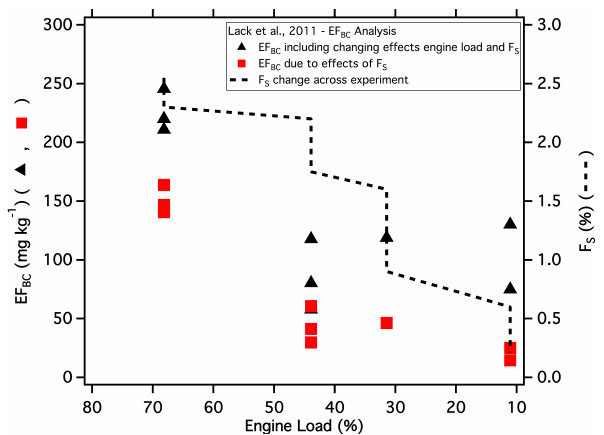
Fig. A1. EF BC changes with engine load (and F S ) from the study of Lack et al. (2011). Red data has the effects of engine load removed, using the average EF BC engine load relationship from Sect. 3 (grey